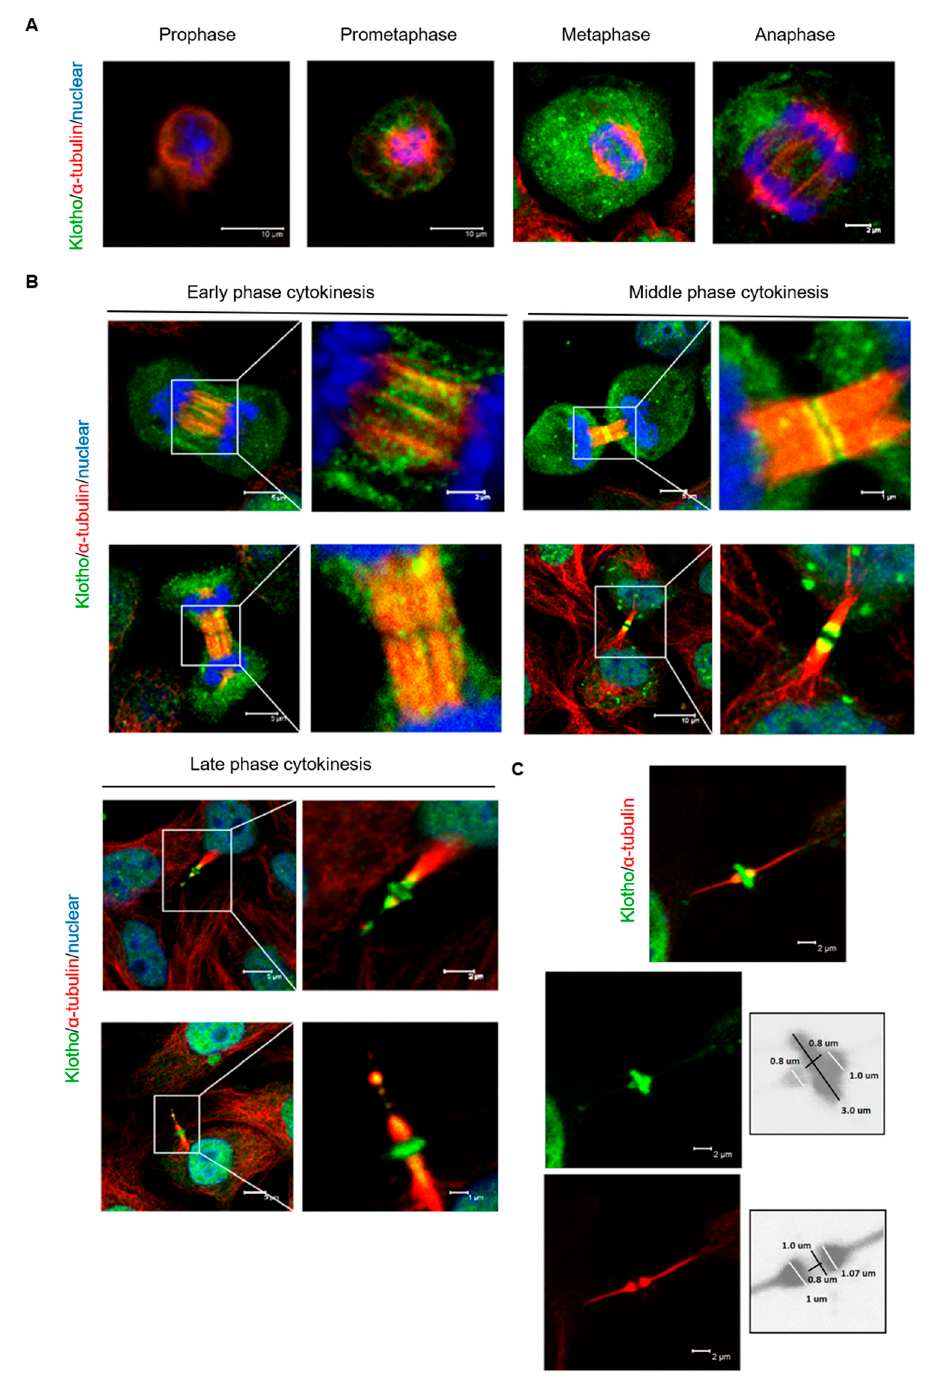
Figure 3. Cellular localization of endogenous Klotho protein during mitosis. Endogenous Klotho protein of cultured HeLa cells was analyzed by immunofluorescence with an N-terminal specific antibody for Klotho. ( A ) Cellular localization of Klotho during the mitotic process from the prophase to the anaphase. ( B ) Cellular localization of Klotho during the cytokinesis. ( C ) Highlight of Klotho ring in the cytokinesis midbody (microscopy: ×